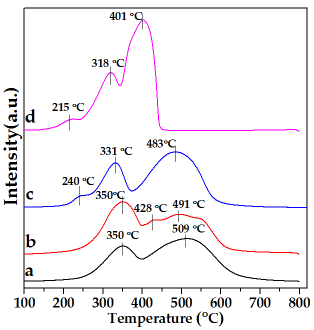
Figure 9. H 2 -TPR curves of as-prepared catalysts: MnCo 2 O 4 -HC ( a ), Mn 0.9 K 0.1 Co 2 O 4 -HC ( b ), Mn 0.8 K 0.2 Co 2 O 4 -HC ( c ), Mn 0.7 K 0.3 Co 2 O 4 -HC ( d